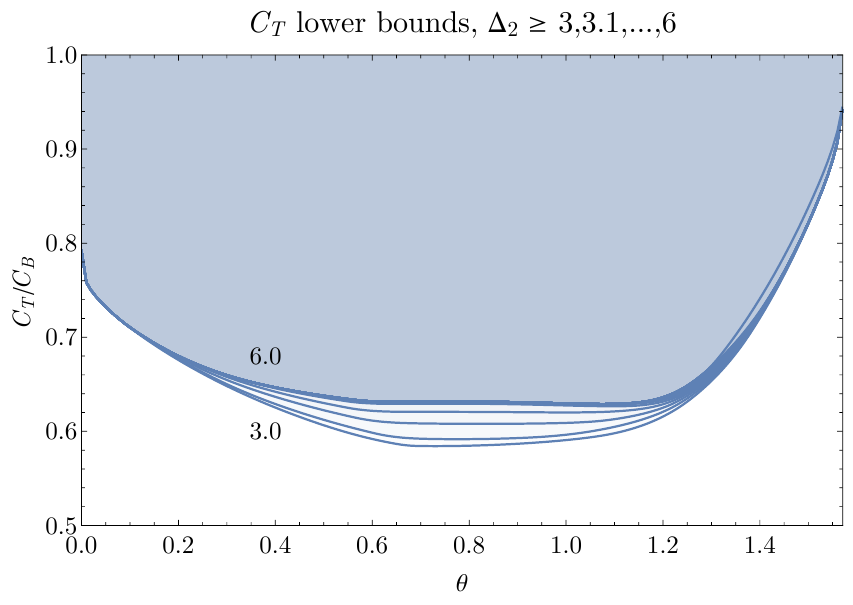
Figure 9 . Lower bounds on C T as a function of (cid:18) in 3d CFTs for di(cid:11)erent gaps between the stress tensor and the second parity-even spin-2 operator.